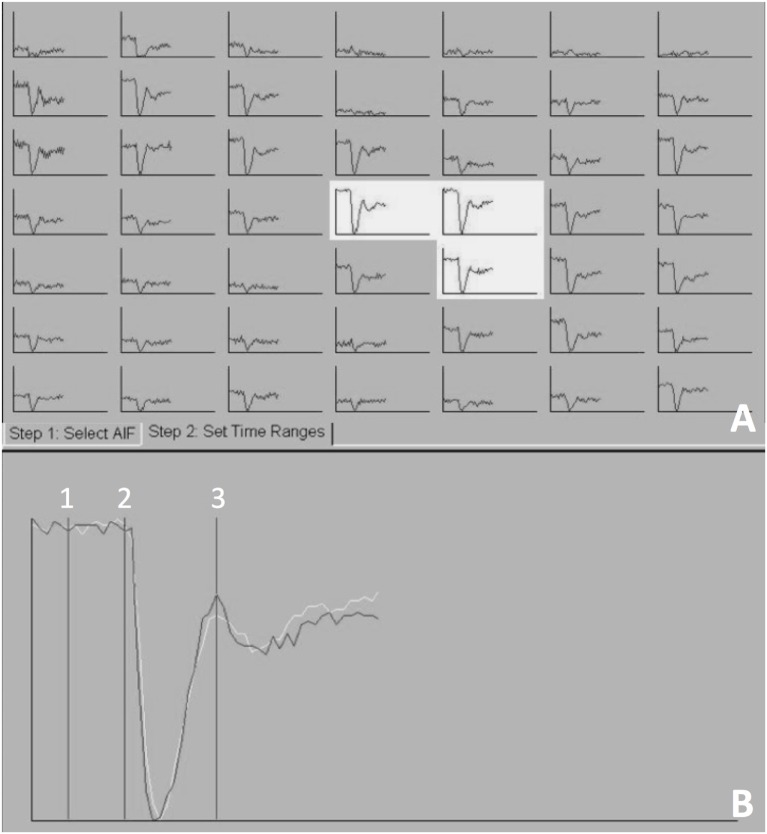
The arterial input function (AIF) generated at the level of the middle cerebral artery, mapping T2*signal (y-axis) against time (x-axis). Three AIF graphs were selected (A) and a representative averaged AIF was generated (B). Three points on the averaged AIF were selected 1—the baseline prior to the contrast arrival, 2—point on the graph immediately prior to signal loss peak, and 3—time immediately after return to baseline.